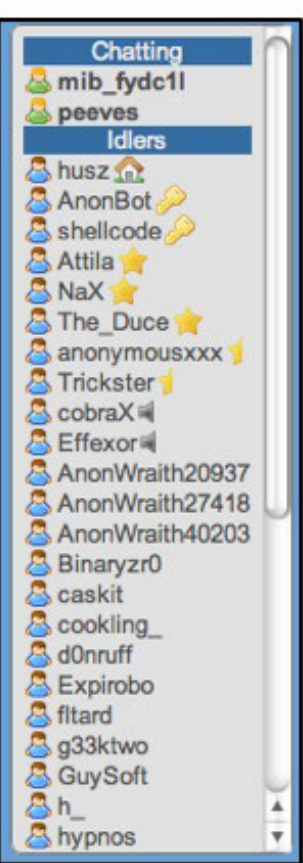
Figure 3: List of users active within an IRC channel and ordered according to privilege (represented by icons next to name). Most senior at the top, user with no privileges listed